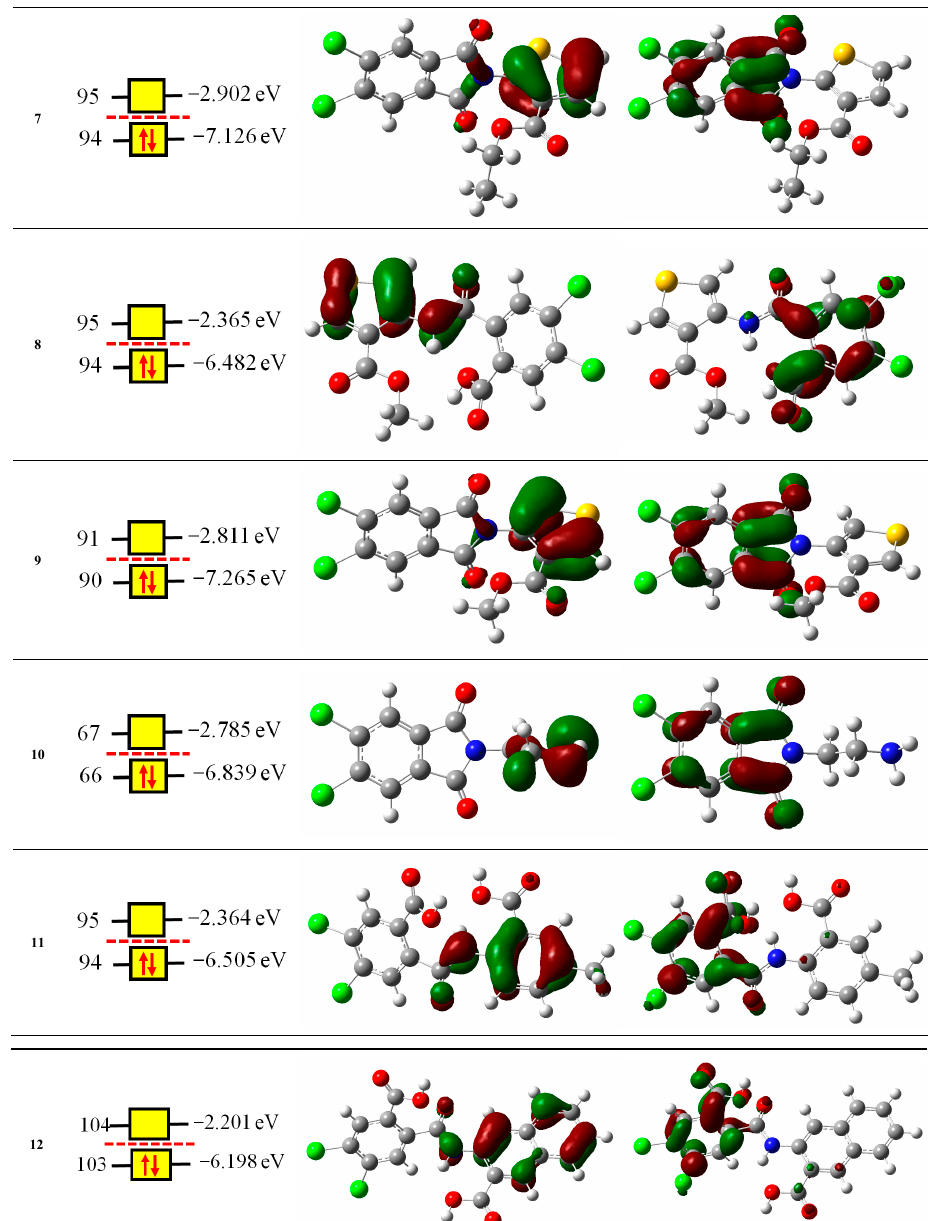
Figure 4. The HOMO and LUMO molecular orbital diagrams of compounds 1 – 12 .